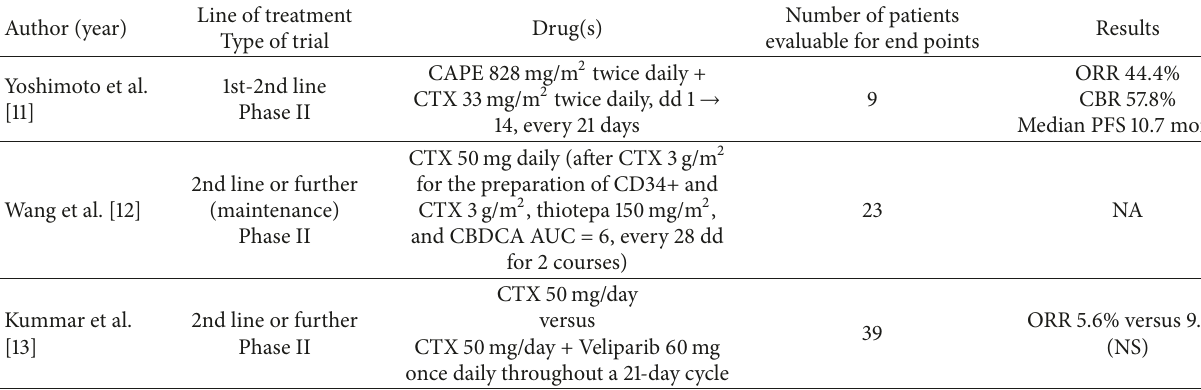
Table 2: Summary of data in the metastatic setting.